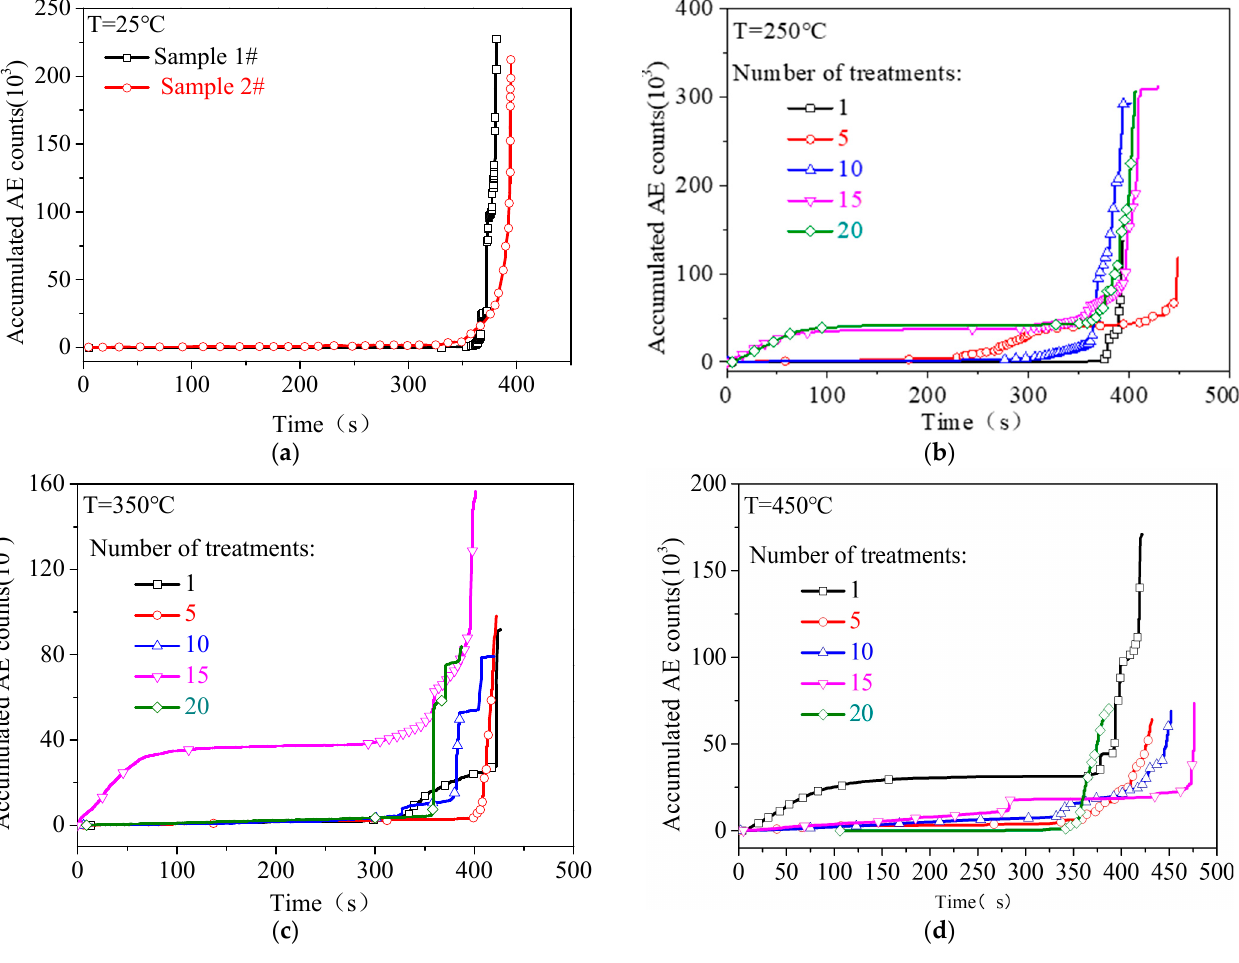
Figure 7. Variation curve of accumulated acoustic emission events of specimens. ( a ) T = 20 °C. ( b ) T = 250 °C. ( c ) T = 350 °C. ( d ) T = 450 °C.